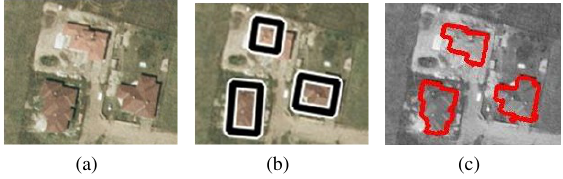
Figure 7: Qualitative comparison of MPP-based and proposed method: (a) is the original image part; (b) shows the result of MPP-based method; (c) is the result of the proposed